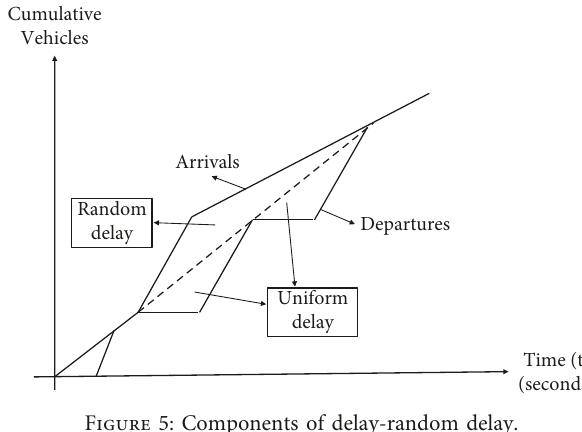
Figure 4: Components of delay-uniform